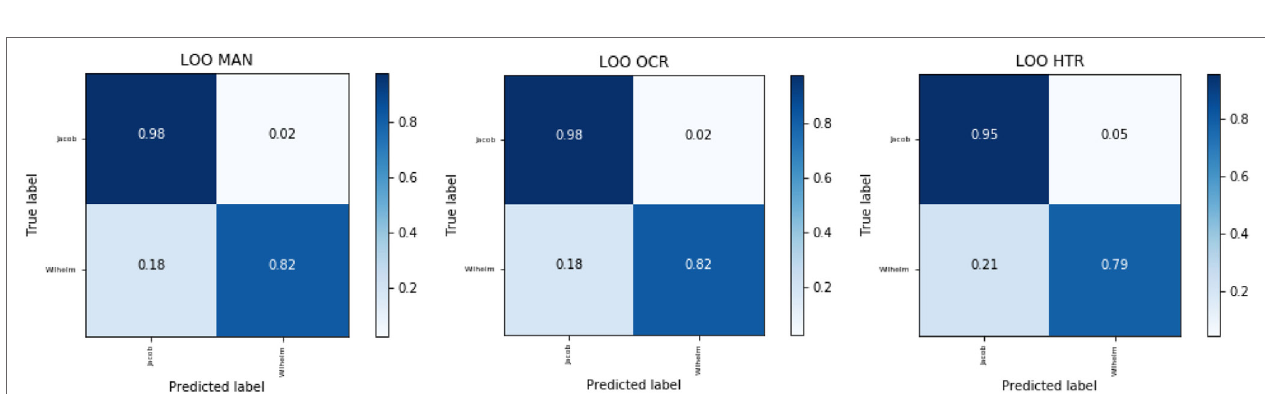
FigUre 8 | Confusion matrices for the leave-one-out validation approach for each of the three data-sets.